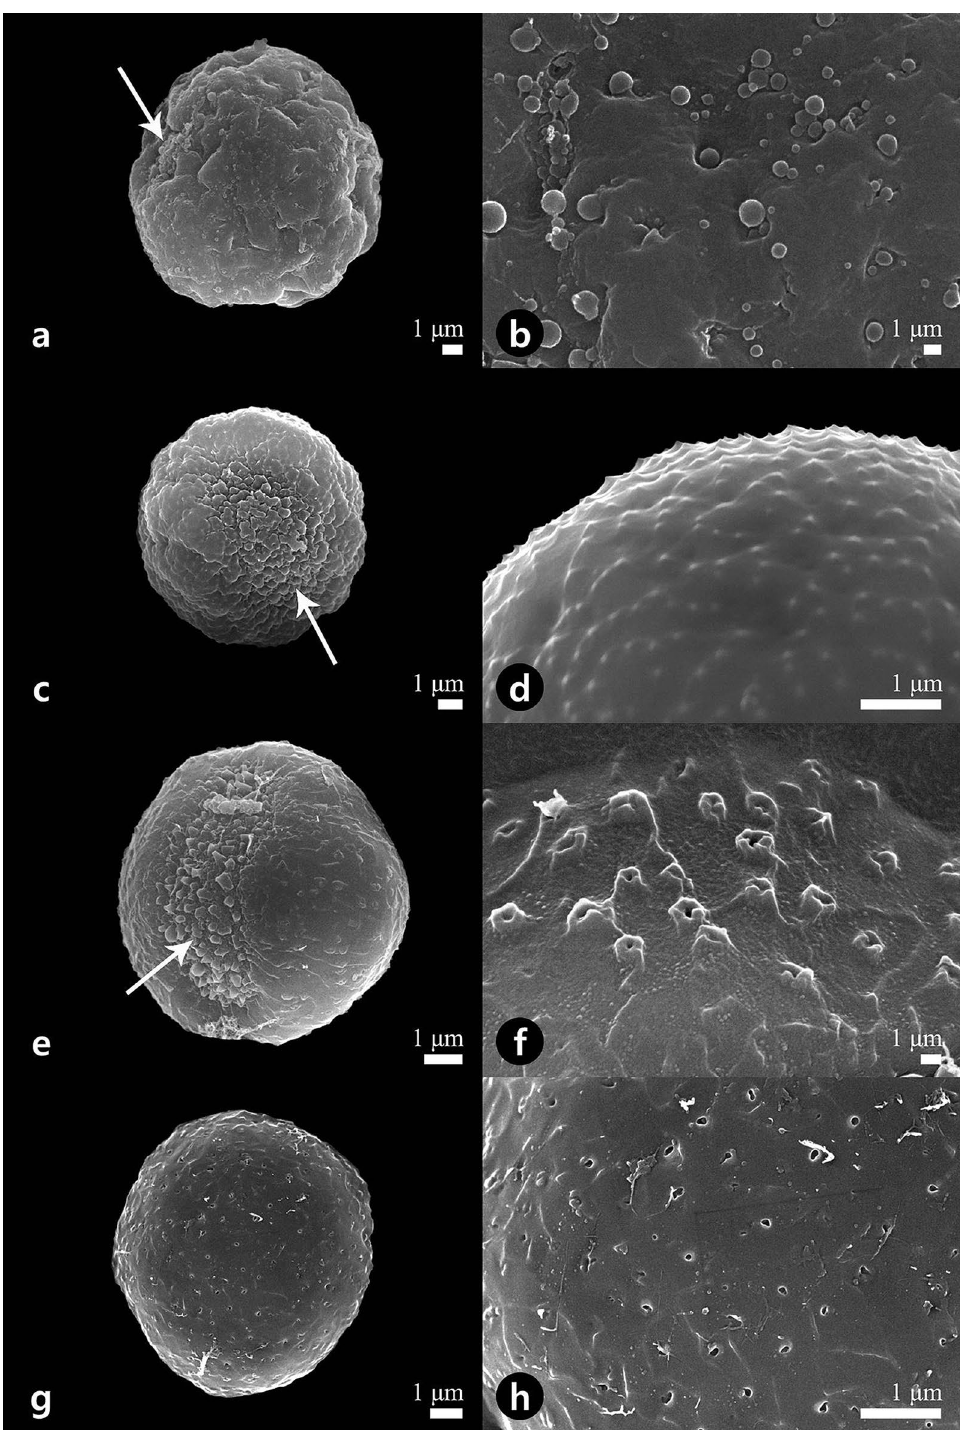
Figure 4. Scanning electron micrographs showing the pollen grains ( a , c , e , g ) and detailed surface ornamentation ( b , d , f , h ). ( a , b ) Houttuynia cordata . ( c , d ) Piper kadsura . ( e – h ) Saururus chinensis . White arrows indicate